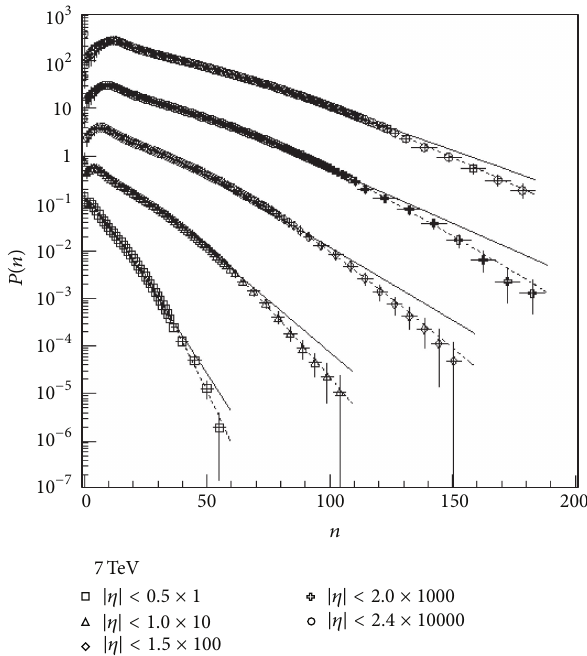
Figure 17: Primary charged hadron multiplicity distributions for = 7 TeV. The solid lines along the data |𝜂| < 0.5 to 2.4 for √𝑠 𝑁𝑁 points correspond to respective single NBD while the dashed lines correspond to the respective of two-NBD. The figure is taken from